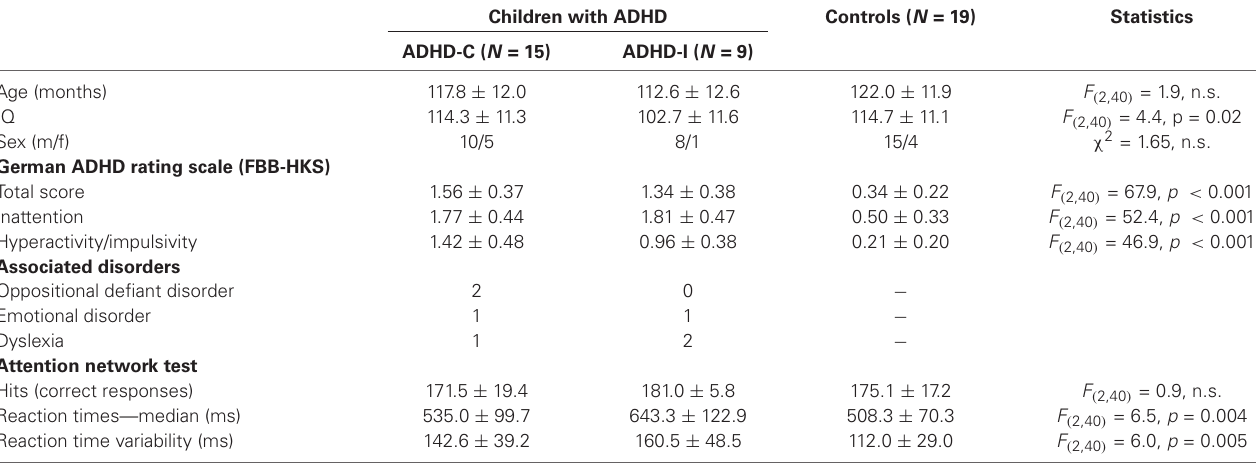
Table 1 | Sample characteristics and performance data of the attention network